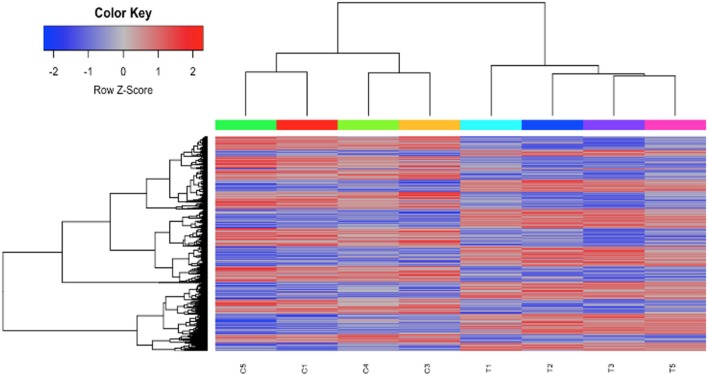
HDAC6i treatment of NZB/NZW F1 mice induced global gene expression changes in whole splenocytes. Hierarchical clustering of 3911 transcripts (1922 up, 1989 down) that differed significantly (FDR < 0.1) between control (C1, C3, C4, and C5) and treated mice (T1, T2, T3, and T5).